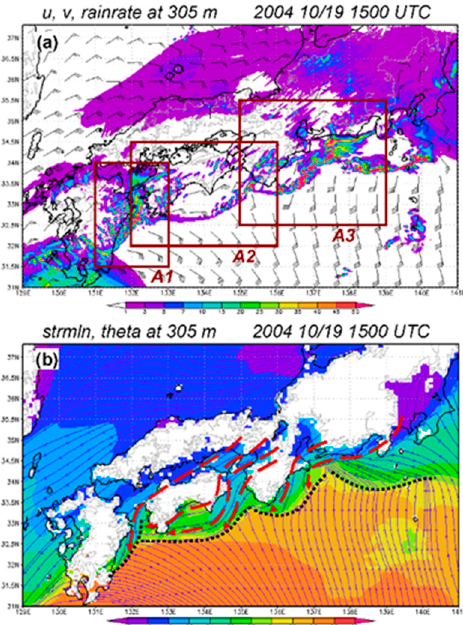
Figure 8. ( a ) The model simulation rainfall rate as in Figure 6 but at 1500 UTC 19 October 2004. The three areas (used in Figure 9) are depicted (brown boxes) and labeled as A1 to A3. ( b ) The model simulated streamlines and potential temperature ( θ , in K, shaded) at 305 m (height contours drawn as thin gray lines) at 1500 UTC 19 October 2004. The positions of rainbands are marked by thick, dotted, black lines, and several streamlines on the cold side are highlighted by thick, dashed, scarlet lines with arrows.